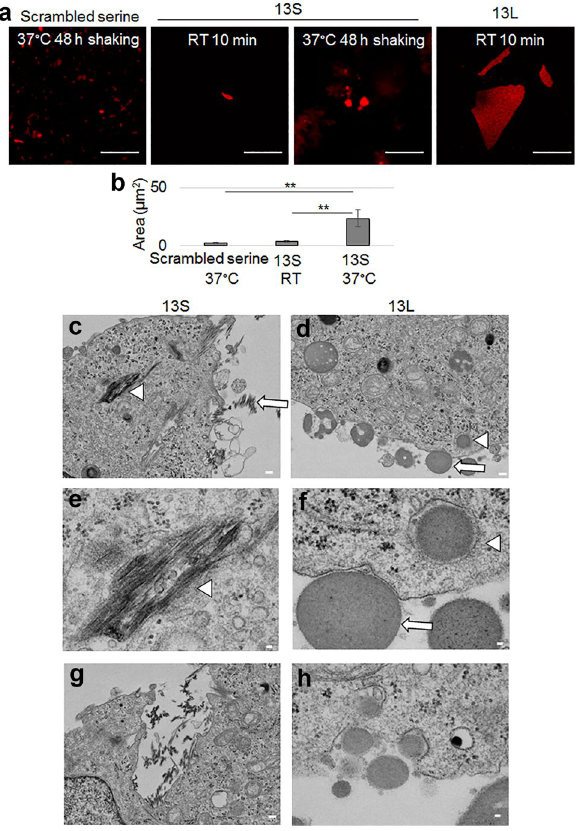
Figure 1. Aggregated 13S and 13L enter PC12 cells. ( a , b ) Fluorescent images of clusters of aggregates of TAMRA-labeled 13S and 13L peptides (1 mg/ml in water, red). 13S and 13L were incubated for 10 min at room temperature. 13S and scrambled serine were also incubated for 48 h at 37 °C with shaking ( a ). Area of aggregates were quantified (n = 20 each) ( b ). ANOVA, ** p < 0.01. Scale bar, 20 µm. ( c – h ) Transmission electron microscopic images of undifferentiated PC12 cells having 13S or 13L. 13S peptide (1 mg/ml in water) was incubated for 48 h at 37 °C with shaking. Then, the aggregated 13S peptide was added in the culture medium of PC12 cells to be at a final concentration of 10 µg/ml. The stock solution of 13L peptide was directly applied in the culture medium to be at a final concentration of 10 µg/ml. The cells having two peptides were incubated for 1 day at 37 °C. Extracellular aggregates (arrows) of 13S ( c ) and 13L ( d ) are shown. 13S ( c , e , g ) and 13L ( d , f , h ) aggregates inside the cells (arrowheads) are also shown. The invaginated vesicles having aggregates inside are also shown ( g , 13S; h , 13L). Scale bars, 20 µm ( a ), 1 µm ( c , d , g ), 200 nm ( e , f , h